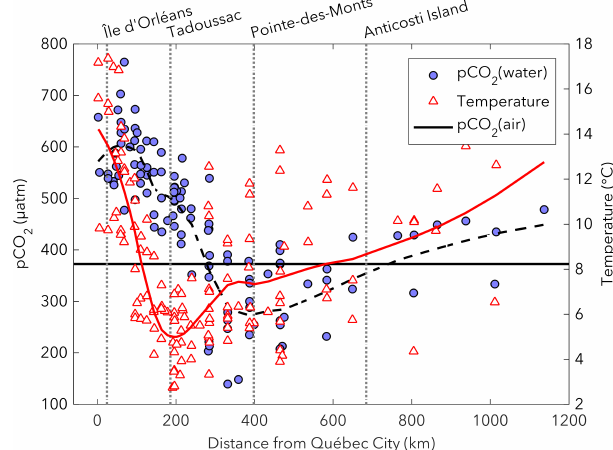
Figure 9. Spatial distributions of surface-water p CO 2 (circles) and temperature (triangles) in the St. Lawrence River, SLE, and GSL during spring and summer cruises. Temperatures ranged from 4.2 to 17.4 ◦ C (generally decreasing) in the USLE, 2.7 to 12.6 ◦ C (gener- ally increasing) in the LSLE, and 3.9 to 13.7 ◦ C (generally increas- ing) in the GSL. The horizontal line shows the mean atmospheric p CO 2 , p CO 2 (air), during all sampling months. The dashed line is the smoothed p CO 2 (water) data using a moving average filter with a span of 50% of the total number of data points, whereas the red line is the smoothed temperature